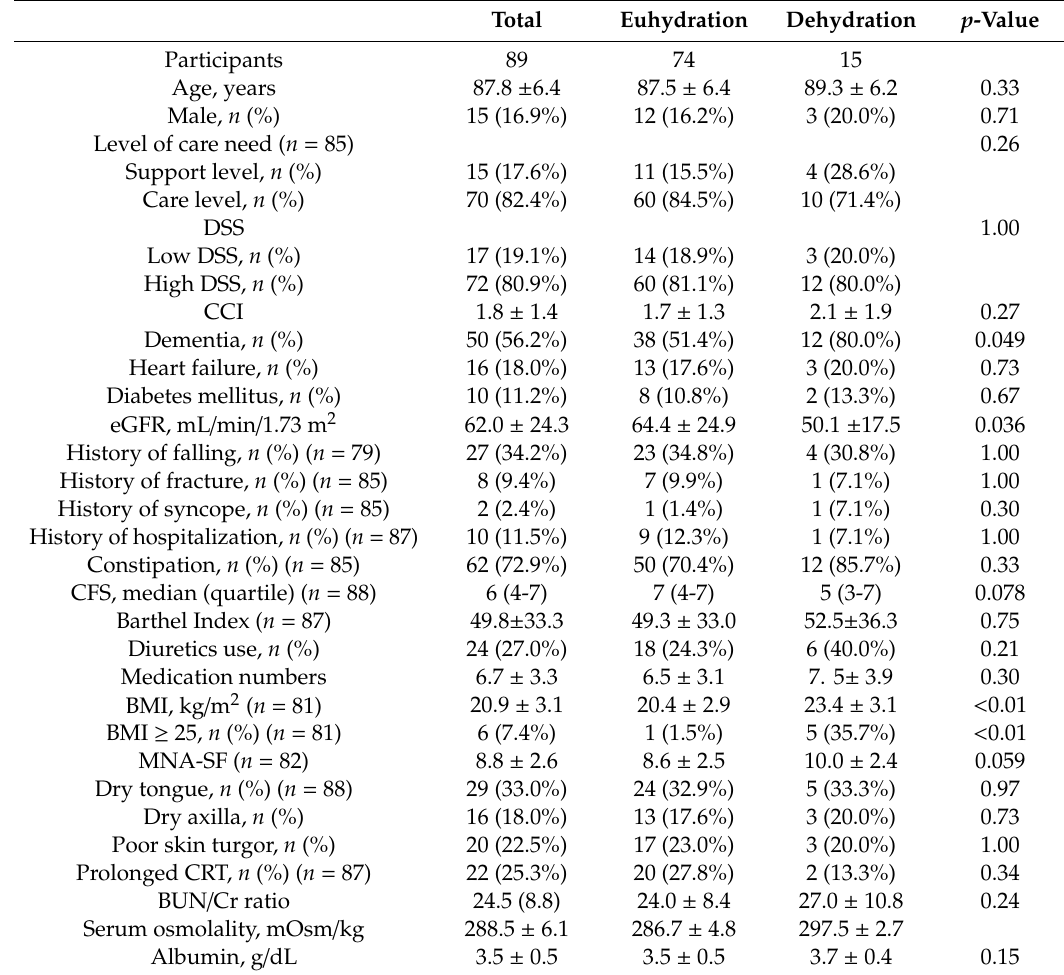
Table 1. Participant